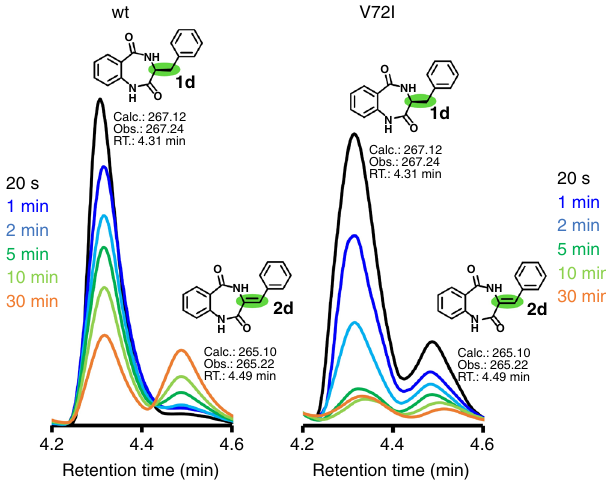
Fig. 4 Activity measurements of wt and engineered AsqJ. Turnover of the wt and V72I-mutated AsqJ for the non-methylated substrate analog ( 1d ) from reverse-phase HPLC/MS-coupled activity assays in the presence of Fe II , α KG, oxygen, and ascorbic acid. The absorbance at λ = 280 nm is shown for 1d and the desaturated reaction intermediate 2d (see Supplementary Fig. 13 for further characterization). The reaction progress was analyzed after 20 s (black trace), 1 min (dark blue), 2 min (light blue), 5 min (dark green), 10 min (light green), and 30 min (orange), showing that 2d forms already after 20 s in V72I